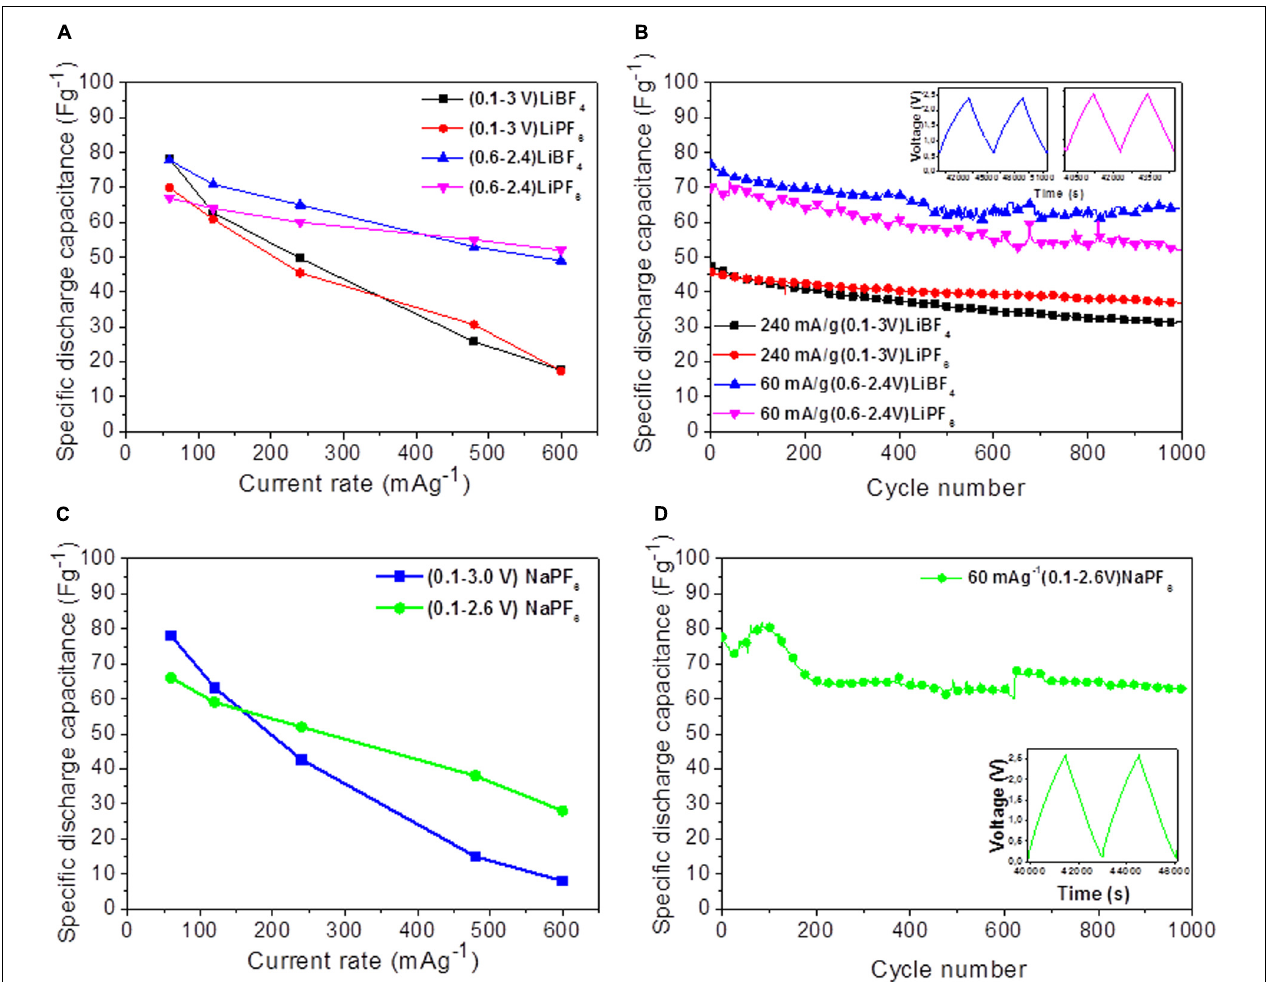
FIGURE 3 | Discharge capacitance as a function of the current rate (A,C) and cycle number (B,D) of symmetric supercapacitors with YP-50F in different electrolytes.